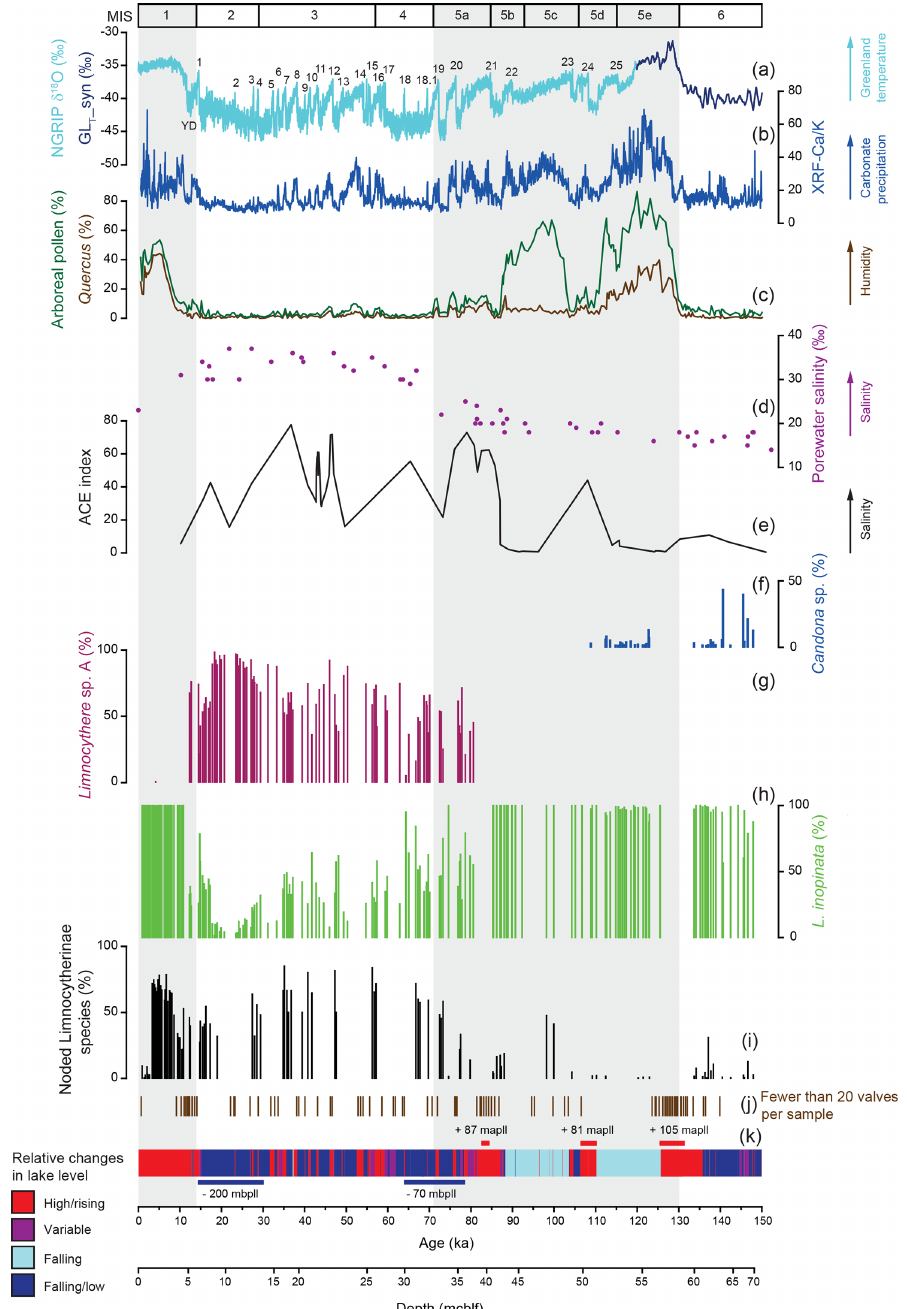
Figure 2. Relative distribution of ostracod taxa in Lake Van in comparison to various palaeoenvironmental proxy records. (a) Isotopic composition of the NGRIP ice core (NGRIP, 2004; Steffensen et al., 2008; Svensson et al., 2008; Wolff et al., 2010) and a synthetic Greenland record (GL T _syn) (Barker et al., 2011). Sedimentary proxies from Lake Van include (b) the XRF Ca / K ratio (Kwiecien et al., 2014), (c) arboreal pollen and Quercus pollen percentage (Litt et al., 2014; Pickarski et al., 2015a, b; Pickarski and Litt, 2017), (d) porewater salinity plotted against depth in metres’ composite below lake floor (mcblf; Tomonaga et al., 2017), (e) biomarker Archaeol and Caldarchaeol Ecometric (ACE) index (Randlett et al., 2017) and (k) lithologies with genetic interpretations related to lake level variability as a coloured bar (simplified according to Stockhecke et al., 2014a) and major lake level variations (Stockhecke et al., 2014a; Tomonaga et al., 2017) in metre above/below present lake level (mapll/mbpll). (f–h) Relative abundance of ostracod taxa. (f) Candona sp., (g) Limnocythere sp. A and (h) Limnocythere inopinata . (i) Percentage of noded Limnocytherinae species. (j) Position of samples containing fewer than 20 valves; these samples were not included in the statistical assemblage analyses. The grey shaded areas represent